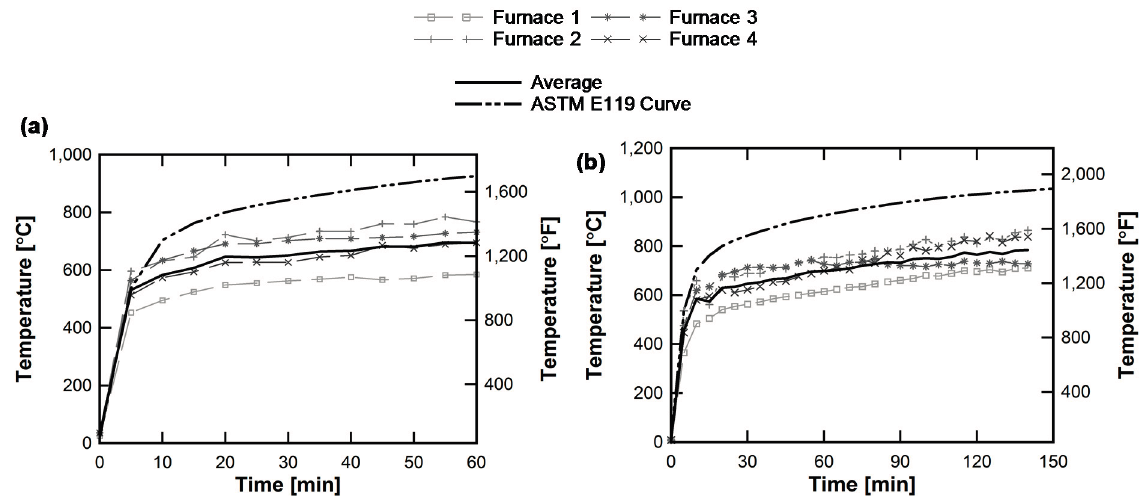
Figure 11. Furnace temperatures for ( a ) 1-Hr and ( b ) 2-Hr tests shown with the American Society for Testing and Materials (ASTM) E119 curve.